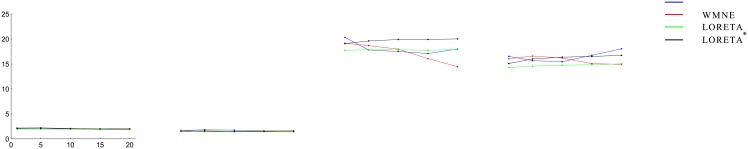
Effects of re-referencing the data.Differences in mean reconstruction errors obtained using the average-reference montage and the single-wire montage for the four inverse methods (MNE (blue), WMNE (red), LORETA (green), and LORETA* (black)) as a function of noise-level and for each of the four combinations of simulated currents (superficial/deep and local/global). Noise-levels are 1, 5, 10, 15, and 20%. The mean errors were obtained by averaging over 500 realizations.